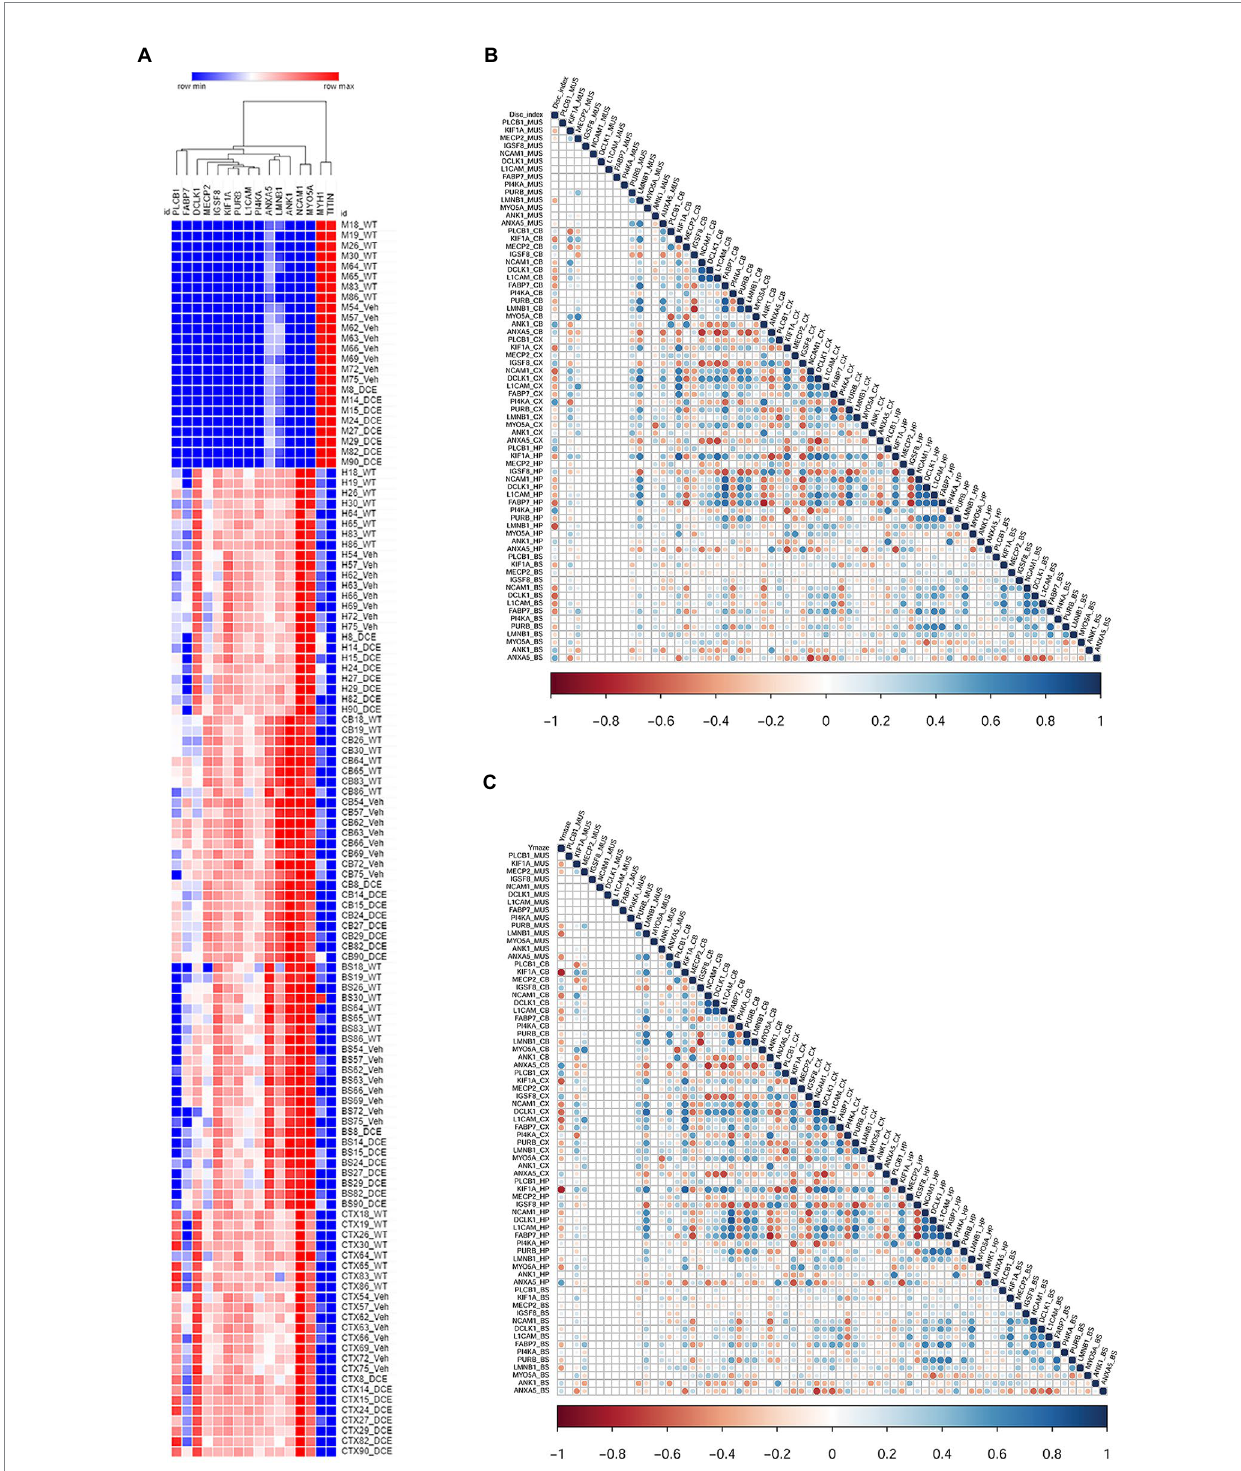
FIGURE 3 Correlation of the levels of 14 proteins with performance in different cognitive tests using a stepwise regression statistical model. (A) Heatmap showing the abundance levels of the 14 proteins that showed significant changes in abundance in both vehicle-treated CrT KO mice and DCE-treated CrT KO mice . (B) Map showing the correlation between the level of each of the 14 proteins with performance in the ORT to evaluate cognition. (C) Maps showing the correlation between the level of each of the 14 proteins and performance in the Y-maze test. The correlation maps were derived using a stepwise regression model to assess the correlation between the abundance each of the 14 differentially expressed proteins and performance in each of the cognitive tests. Group comparisons were carried out using a statistical model based on one-way ANOVA followed by Bonferroni’s post hoc test for multiple